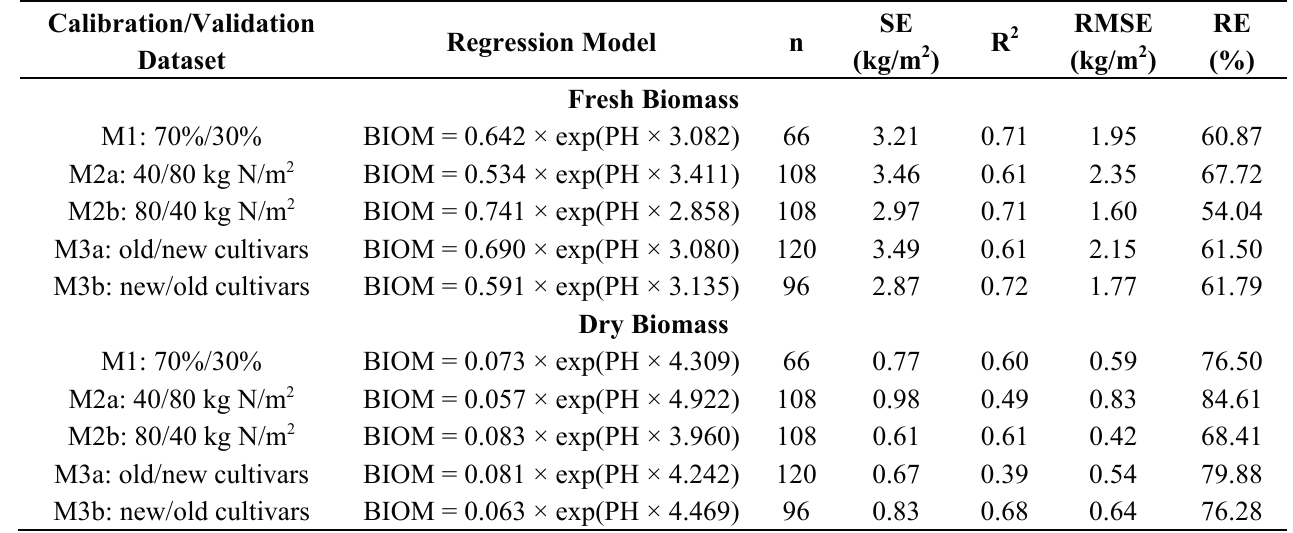
and PH for all plots (n = 216). R 2 = coefficient of ref CSM